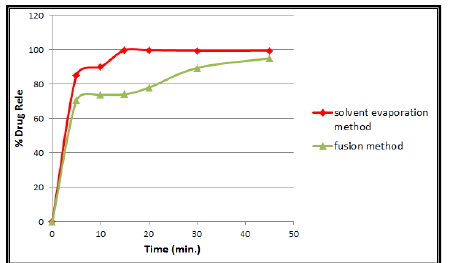
Figure 7.Effect of preparation methods on the release of EXB from PXM 407 solid dispersion of ratio (1: 5) in phosphate buffer